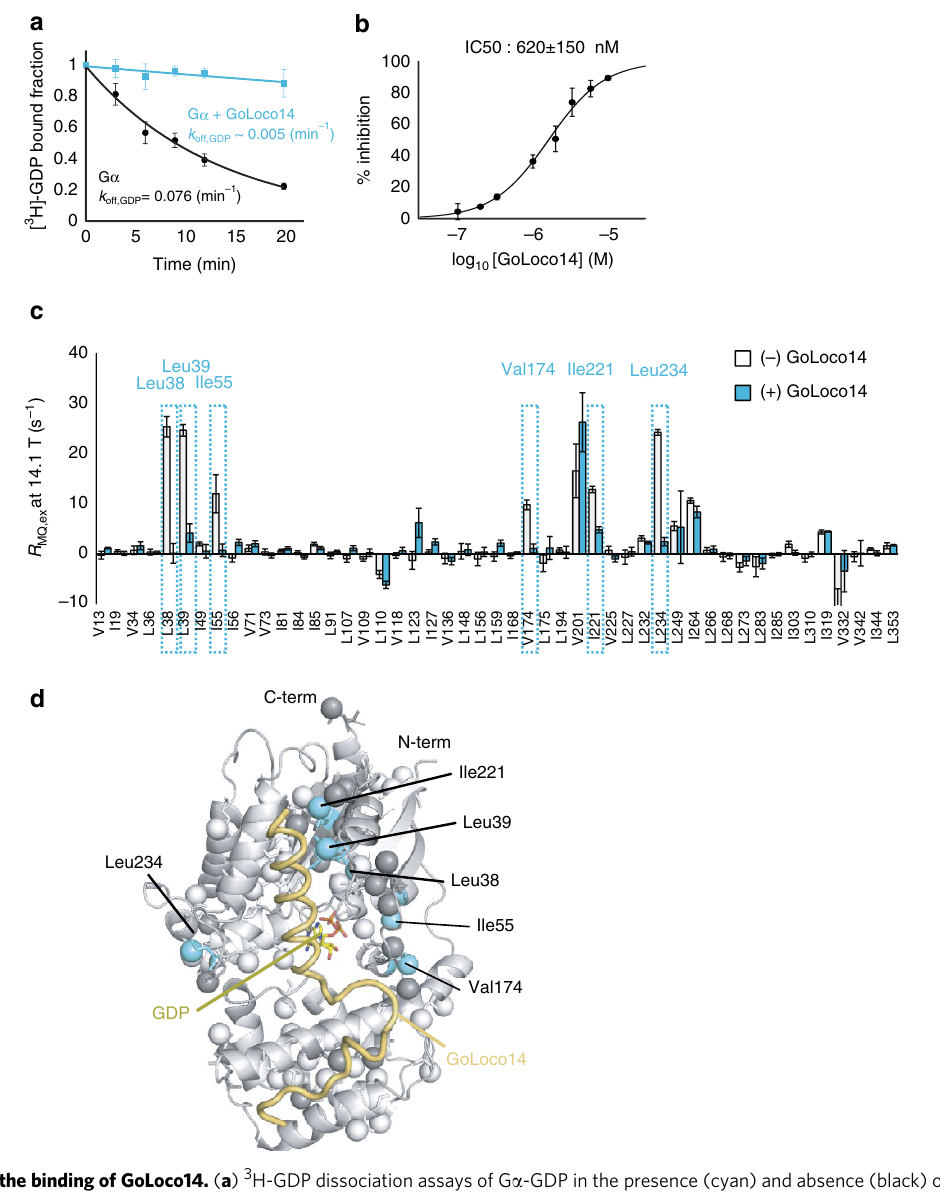
Figure 5 | Effects of the binding of GoLoco14. ( a ) 3 H-GDP dissociation assays of G a -GDP in the presence (cyan) and absence (black) of 10 m M GoLoco14. The experiments were performed at 30 (cid:2) C. Each point reflects mean ± s.e.m. of three independent experiments. ( b ) Plot of the percentage inhibition of the 3 H-GDP dissociation against the concentration of GoLoco14. The percentage inhibition was calculated from the amount of bound 3 H-GDP after a 10min incubation in the presence of various concentrations of GoLoco14 (100nM to 10 m M). The calculated IC50 value was 620 ± 150nM. Each point reflects mean ± s.e. of three independent experiments. ( c ) Plots of the R MQ,ex rates in the presence (cyan) and absence (light grey) of GoLoco14 at 14.1 Tesla (600MHz 1 H frequency). The error bars represent s.d. of fitting errors, estimated from Monte Carlo simulations using uncertainties in peak intensities. The methyl groups with reduced R MQ,ex rates in the presence of GoLoco14 are highlighted. We suppose that the increase in the R MQ,ex rates of Val201 is mainly due to the change in the D $ value, induced by the binding of GoLoco14 ( B 0.4p.p.m., Supplementary Fig. 8b). ( d ) Mapping of the methyl groups with reduced R MQ,ex rates in the presence of GoLoco14 on the structure of GoLoco14-G a (cid:3) GDP (PDB ID: 1KJY) 39 . The methyl groups with reduced R MQ,ex rates in the presence of GoLoco14 are coloured cyan. Methyl groups with no data are coloured